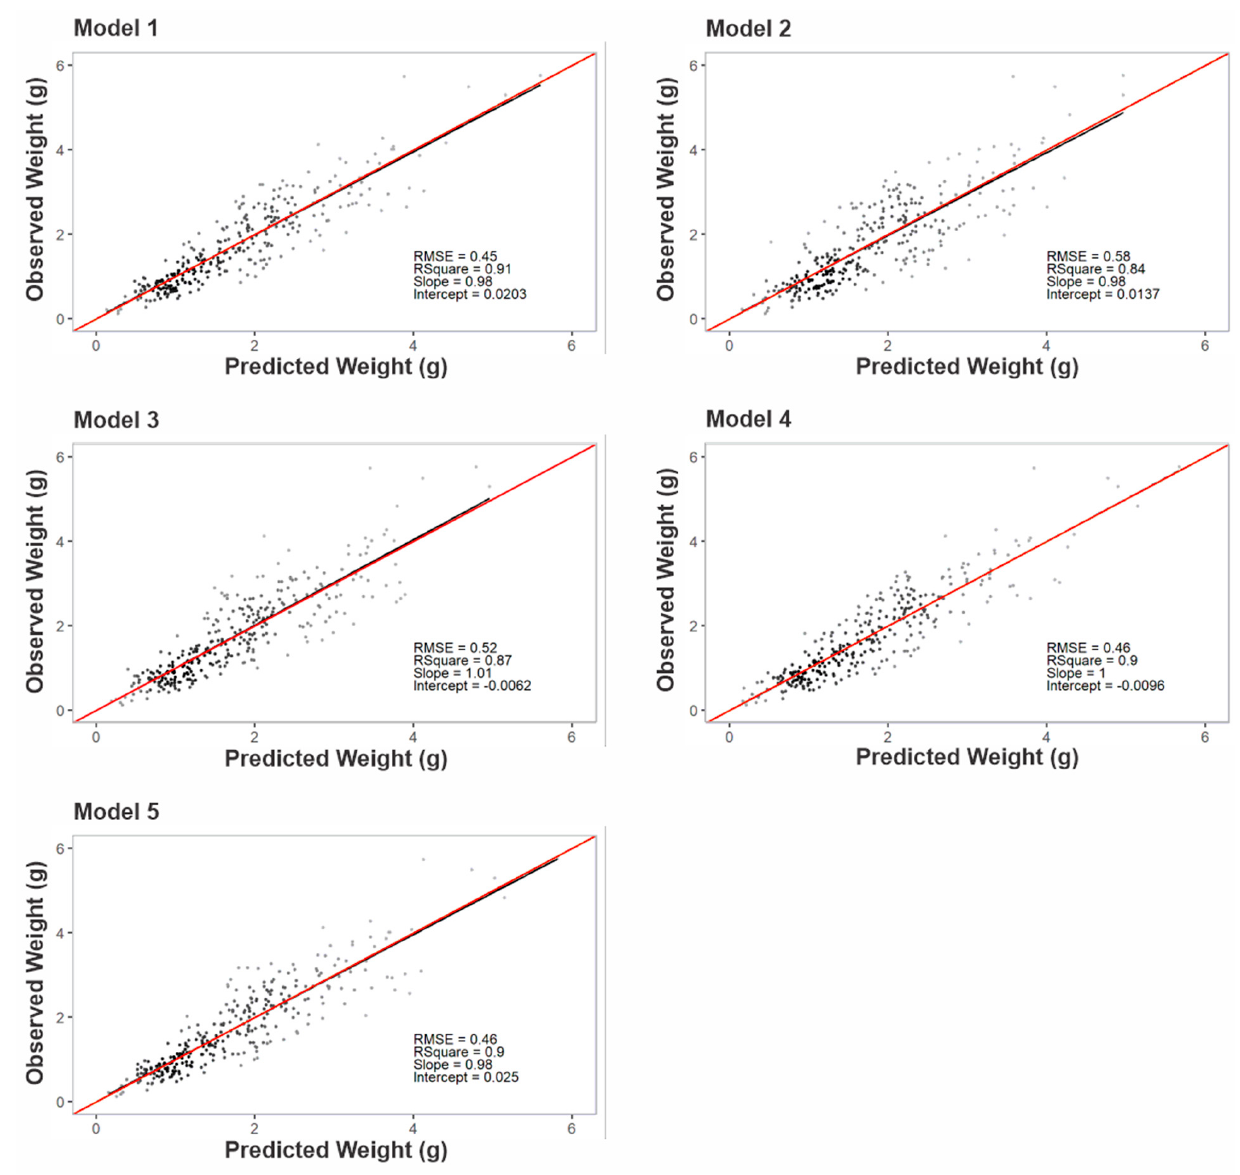
Figure 4. Relationship between the observed weight and the predicted leaf total area of improved lines of common bean for the five evaluated models. Regression line of observed versus predicted values: red line, reference line (x = y): black line.